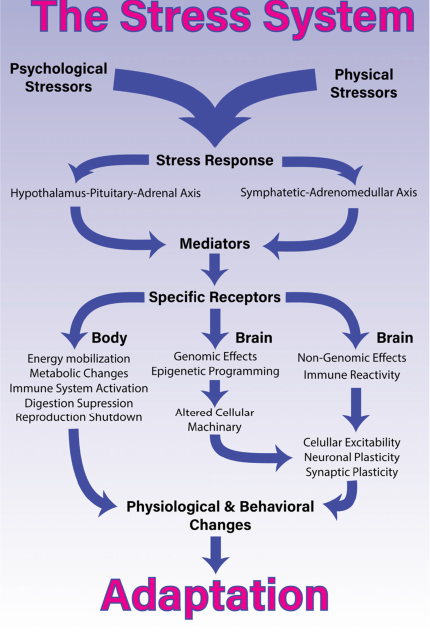
Figure 3. The stress system. “The stress system. Processing and coping with stressful situations requires the engagement of complex mechanisms that integrate brain and body. The response to stressful stimuli is articulated by a wide diversity of brain structures that collectively are able to detect or interpret events as either real or potential threats (stressors). The perception of these events as stressors involves different networks depending on whether it is a physical or psychological stressor. The identification of a stressor leads to activation of two major constituents of the stress system and the release of its final mediating molecules. The sympathetic-adreno-medullary (SAM) axis, secretes epinephrine [adrenalin] and norepinephrine [noradrenalin] and the hypothalamus- pituitary-adrenal (HPA) axis, secretes glucocorticoids. Once these axes are activated in response to a given stressor, they will generate a coordinated response that starts within seconds and might last for days, providing quick responses enabling both an appropriated strategy almost immediately, and homeostasis restoration. To accomplish this, the stress response systemically promotes energy mobilization, metabolic changes, activation of the immune system, and suppression of the digestive and reproductive systems. More specifically in the brain, the stress response induces short- and long-term effects through non-genomic, genomic and epigenetic mechanisms. These central effects, combined with pro-inflammatory signalling, lead to alterations in cellular excitability as well as synaptic and neuronal plasticity. Collectively, these body-brain effects mediate alterations in physiology and behaviour that enable adaptation and survival” [59] (p. 3). Non-genomic effects of glucocorticoids include, for example, the stimulation of both endocannabinoid production and